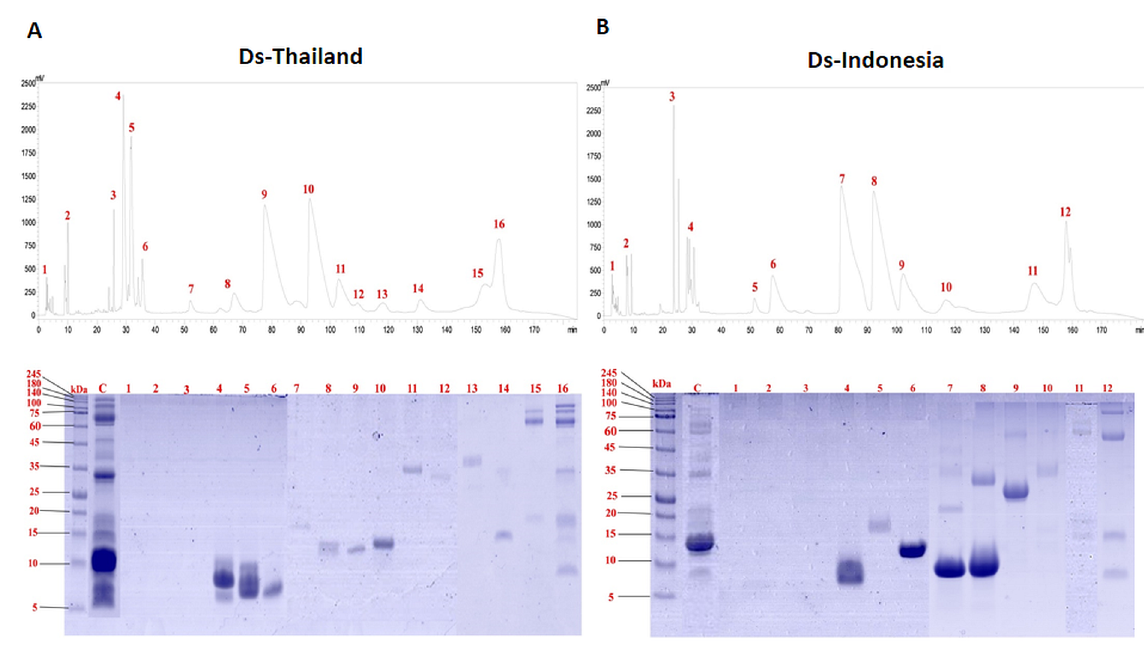
Figure 1. Protein decomplexation of Daboia siamensis venom from (A) Thailand and (B) Indonesia. Upper panel: C18 reverse-phase high-performance liquid chromatography (HPLC) profile of the venom. Lower panel: 15% sodium dodecyl sulfate-polyacrylamide gel electrophoresis (SDS-PAGE) of the protein fractions, under reducing conditions. Lane C: whole